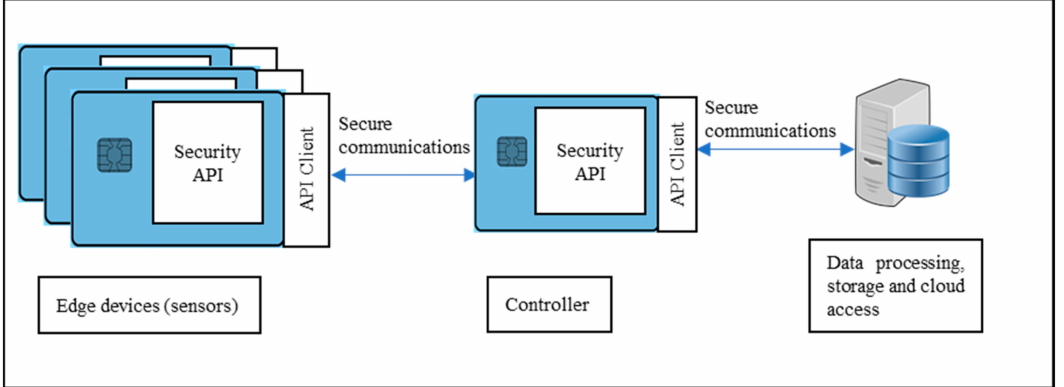
Figure 4. Configuration 3: “Thin secure element” is used in both edge devices and controller. In this case, the controller lacks the processing resources to utilise standard security libraries to provide secure